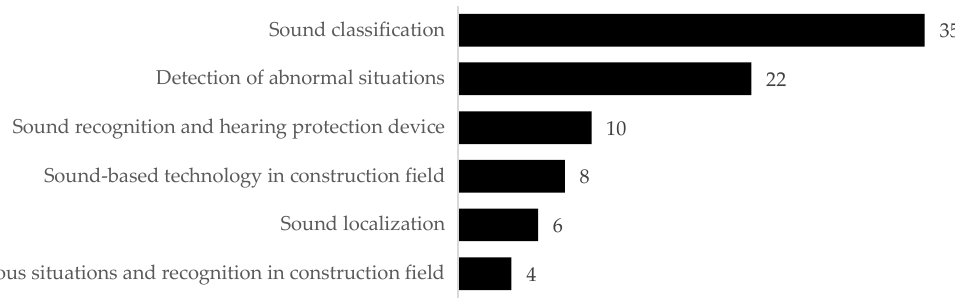
Figure 5. The number of reviewed articles by main contents.